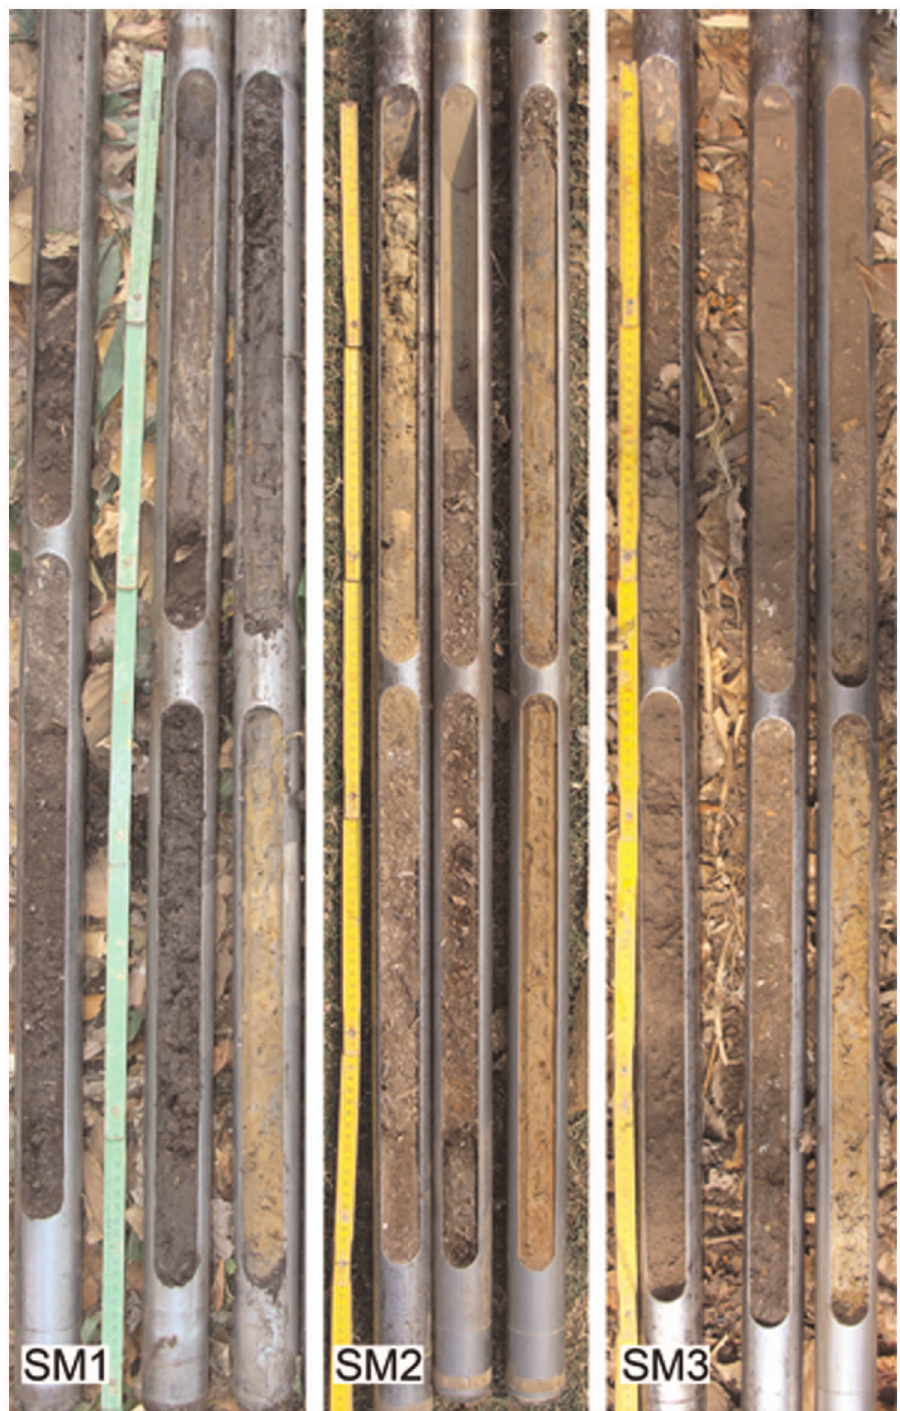
Figure 2. Photographs of the 3 meter cores extracted from the SM1, SM2 and SM3 sites. The thickness of the anthropogenic sediments is 2.5, 1.7 and 2.5 meters respectively. In SM2 the first 50 cm are made of sediments that have been deposited on top of the archaeological site in modern times.